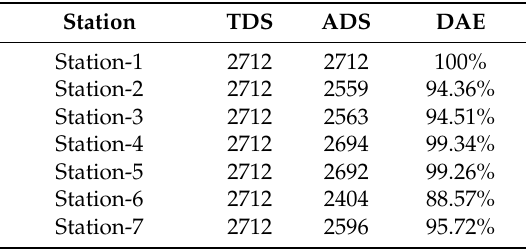
Table 2. Actual acquisition comparison of multiple station. Theoretical data size (TDS) indicates the volume of data that should be acquired at the normal acquisition frequency within three months. Actual data sizes (ADS) indicates results that are counted by real data. Then, using the equation data acquisition efficiency DAE = ADV/TDV acquired the data integrity rate of the device.